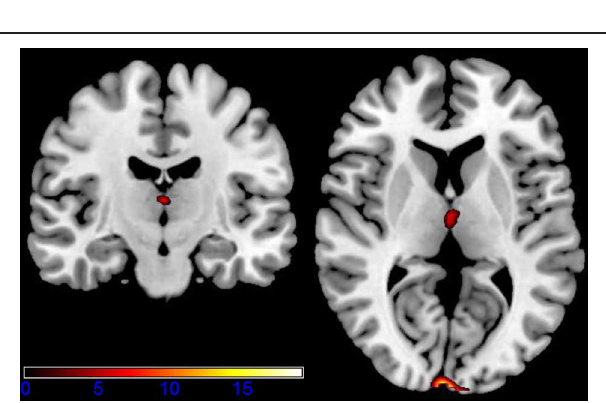
FIGURE 3 | Axial and coronal slices showing significant activation for the main effect runs (for a detailed description of the analysis, please see text; p < 0 . 001 uncorrected for whole-brain volume analysis; for a moredetaileddescriptionofactivatedbrainregions,pleaseseeTable